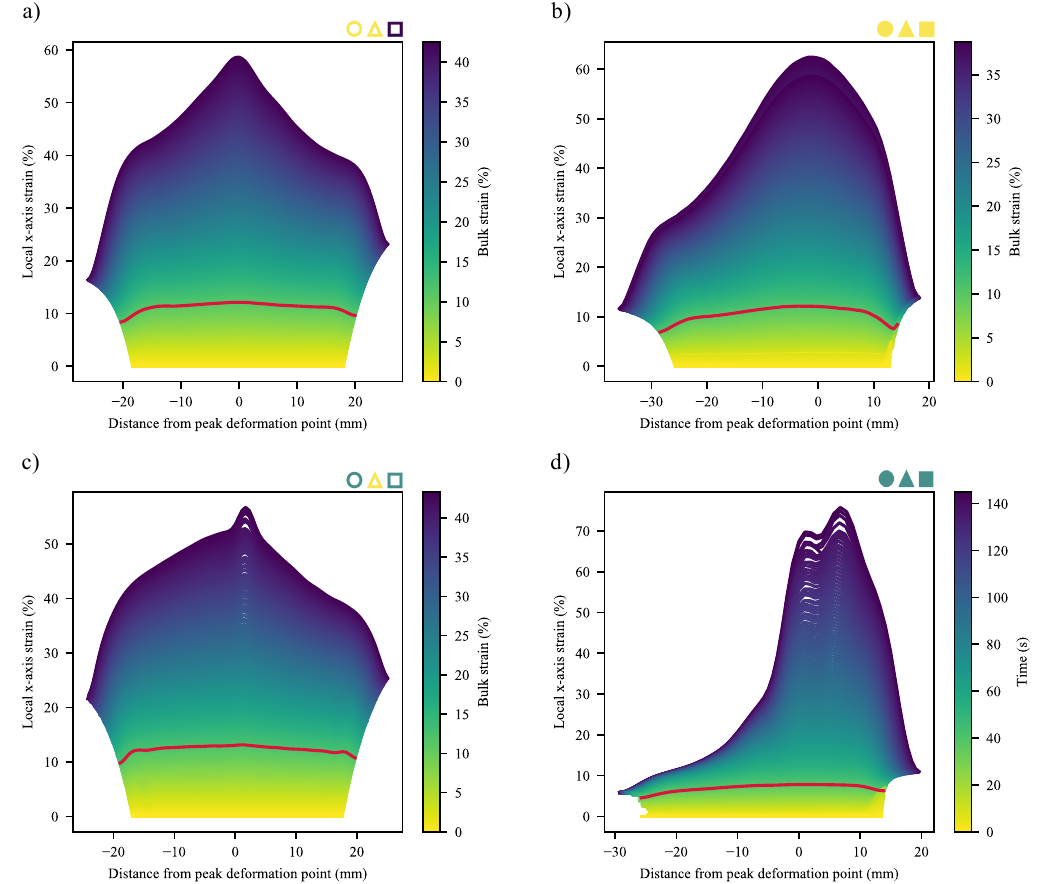
Figure 21. Time-series deformation profiles: last viable instance. ( a ) 0-CB/0-CC/0.5-SP, WL; ( b ) 0-CB/0-CC/0-SP, REF; ( c ) 1.8-CB/0-CC/0.25-SP, WL; ( d ) 1.8-CB/30-CC/0.25-SP, REF. The yield profiles are highlighted in